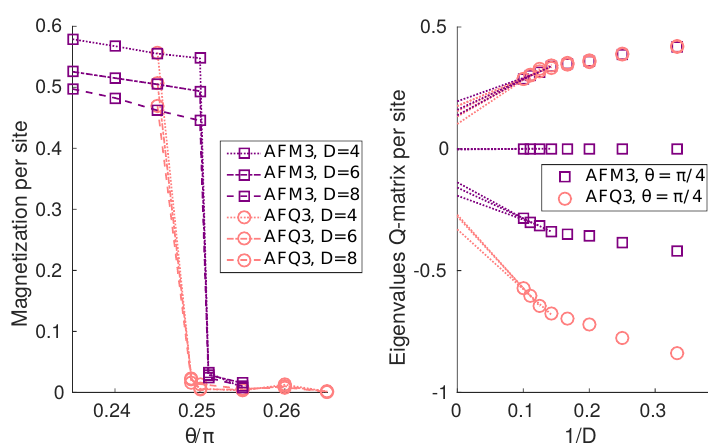
Figure 15: Left: magnetization per site for D = 4,6,8 as a function of the coupling parame- ter θ for the 120° magnetically ordered (AFM3) and antiferroquadrupolar (AFQ3) phases— hysteresis can be observed. Right : eigenvalues of the Q -matrix for the AFM3 and AFQ3 states at the phase transition at θ = π/ 4 for D = 3,4,...,10. Extrapolating D → ∞ shows a jump in the spectrum of the Q